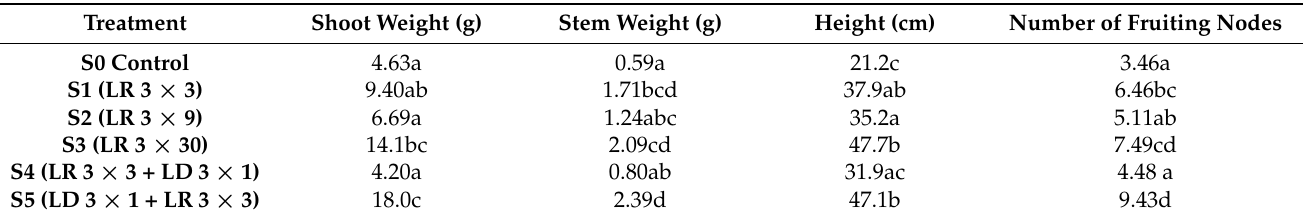
Table 5. Selected biometric traits of the lateral branches of plants grown from control and laser- stimulated seeds.